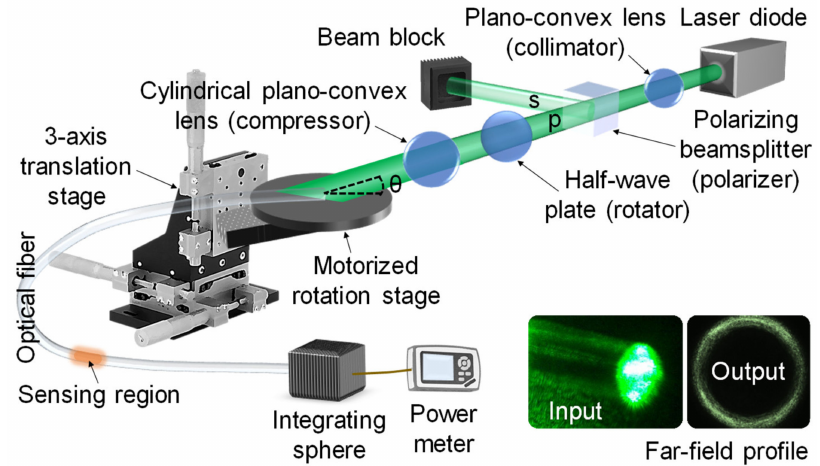
Figure 11. Experimental setup for the enhanced detection and quantification of Rhodamine B. © 2019 IEEE. Reprinted, with permission, from